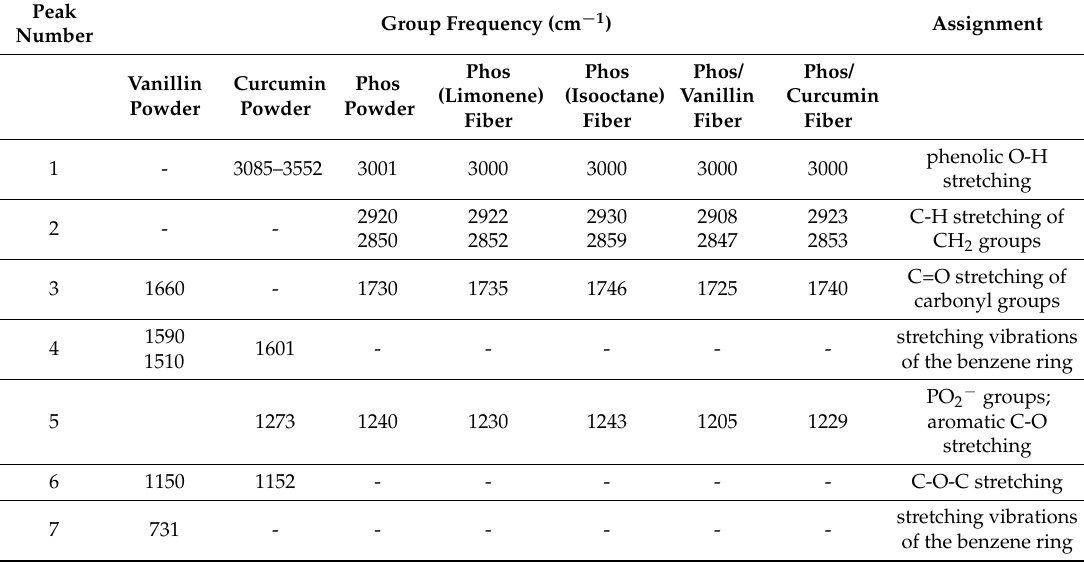
Table 1. IR peak assignment of the electrospun phospholipid (Phos) fibers.